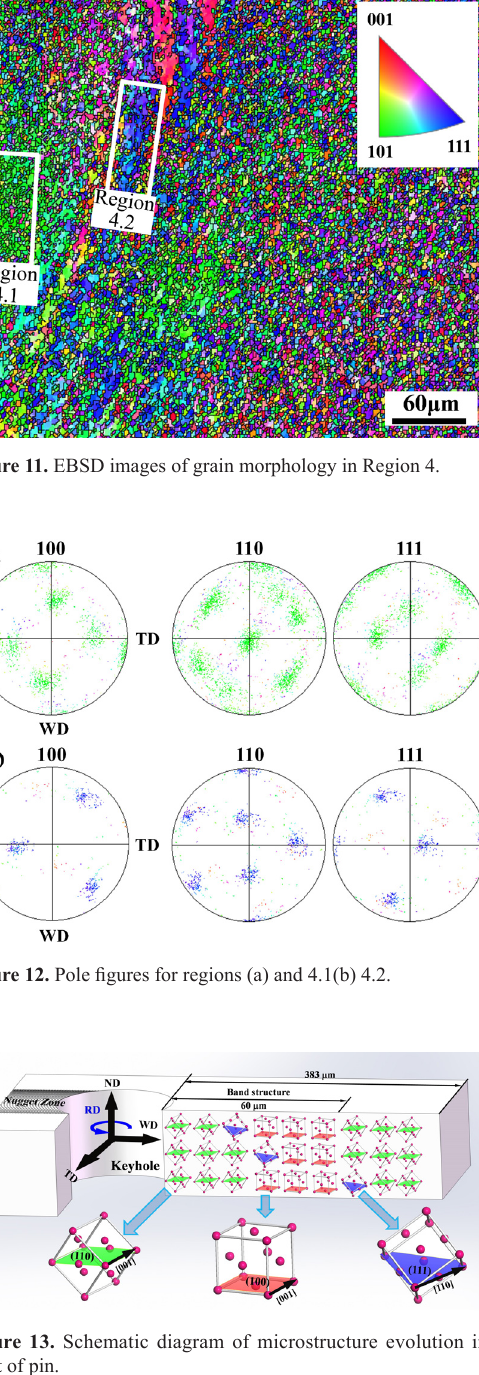
of FSW, the base metal is transferred from the front of the pin to its rear, and a material flow zone is formed between the pin and the base metal during the transfer process. F.C. Liu 32 expressed the mathematical relationship between thickness of material flow zone δ (μm) and the bending forces component through a large number of tests as